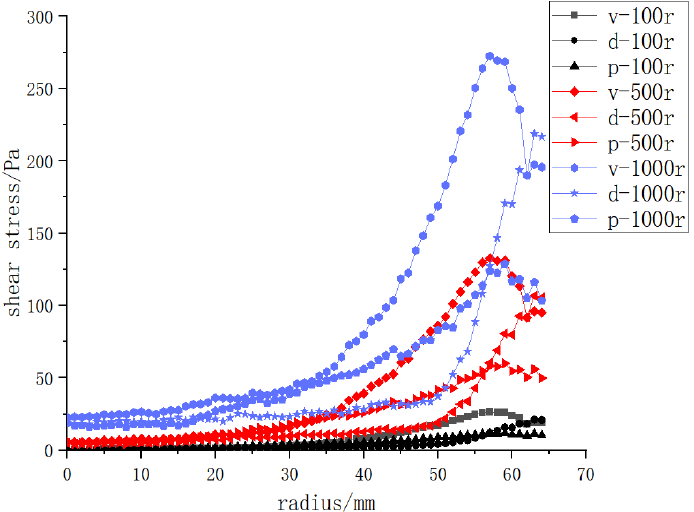
Figure 9. The shear force on the membrane surface at rotating speeds of 100, 500 and 1000 r/min; d: disk, p: